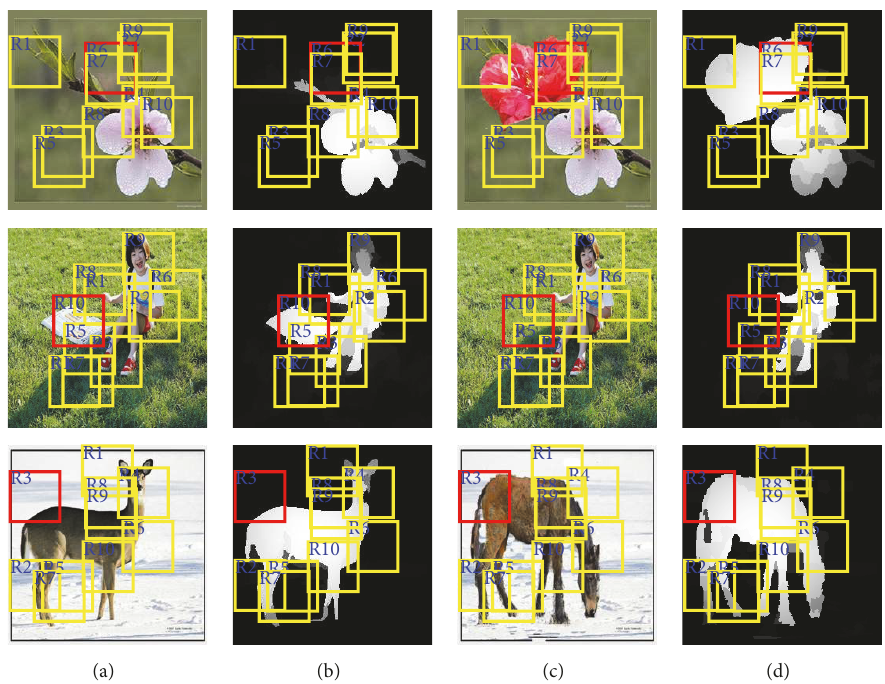
Figure 3: Metric distance for tamper detection (row 1, Image A: object add, row 2, Image B: object delete, and row 3, Image C: object modify) based on salience map. (a) Original image, (b) Original saliency map, (c) Tampered image, and (d) Tampered saliency map. Ten regions with different salient map weights (colored rectangles) are selected for metric distance computing. Regions 𝑅 6 , 𝑅 10 , and 𝑅 3 corresponding to images A-C contribute the max distance for tamper detection.